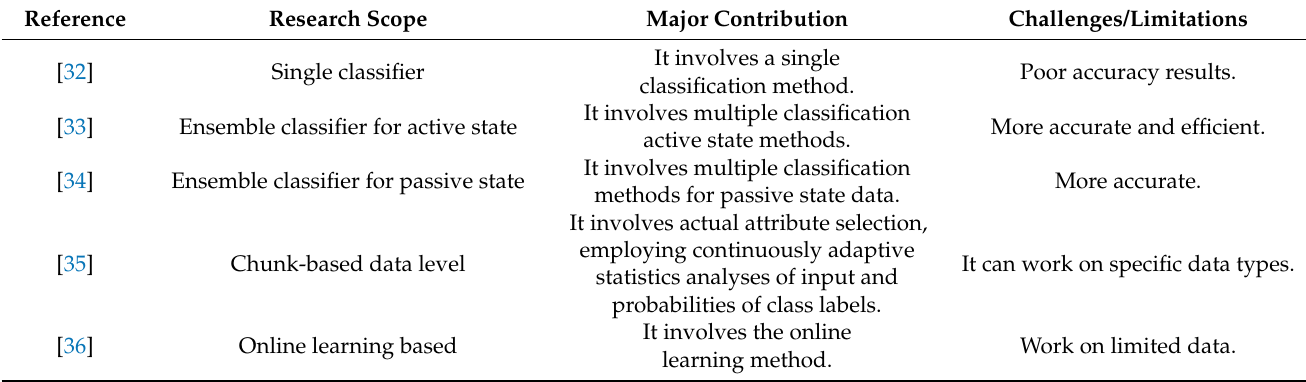
Table 4. Comparisons of current research for handling the concept of drift and model decay in